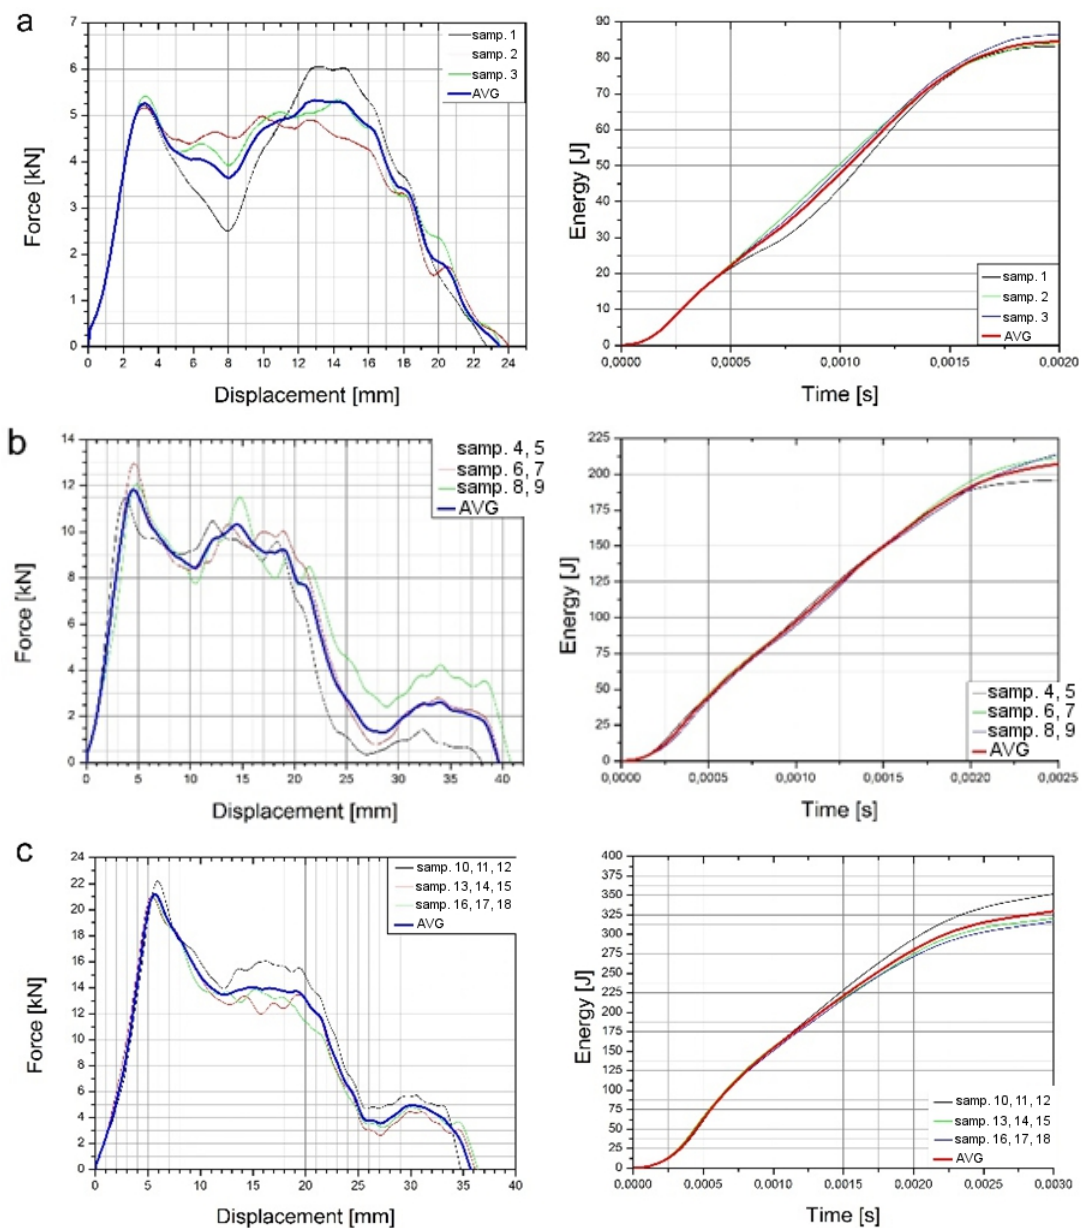
Figure 10. Force–displacement relations during puncture and energy during puncture charts for 1 plate ( a ), 2 plates ( b ), and 3 plates ( c ).